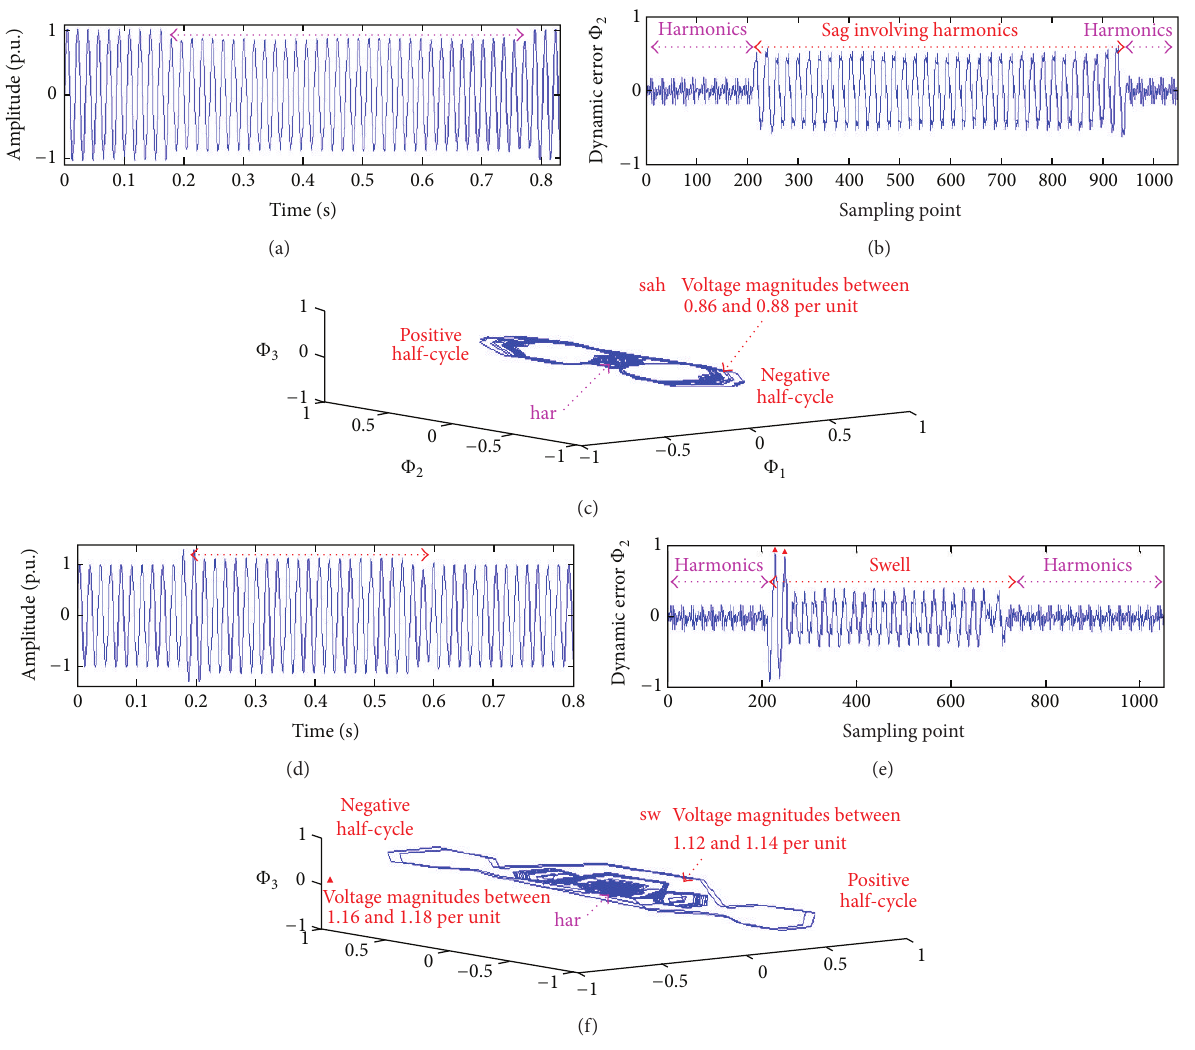
Figure 6: (a) Voltage sag involving harmonics in the time-domain, (b) dynamic errors for har and sah events, (c) motion trajectories of butterfly patterns for har and sah events, (d) voltage swell involving harmonics in the time-domain, (e) dynamic errors for har and swh events, and (f) motion trajectories of butterfly patterns for har and swh